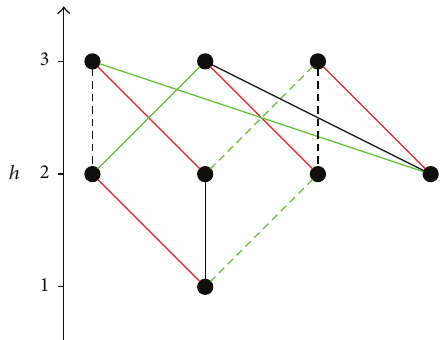
Figure 1: Example of a 1D Adinkra with 3 colors. The coloring is represented by colors on the edges. The dashing is represented by having a dashed edge if 𝜇(𝑒) = 1 and a solid edge if 𝜇(𝑒) = 0 . The grading is represented by the vertical height as indicated on the axis on the